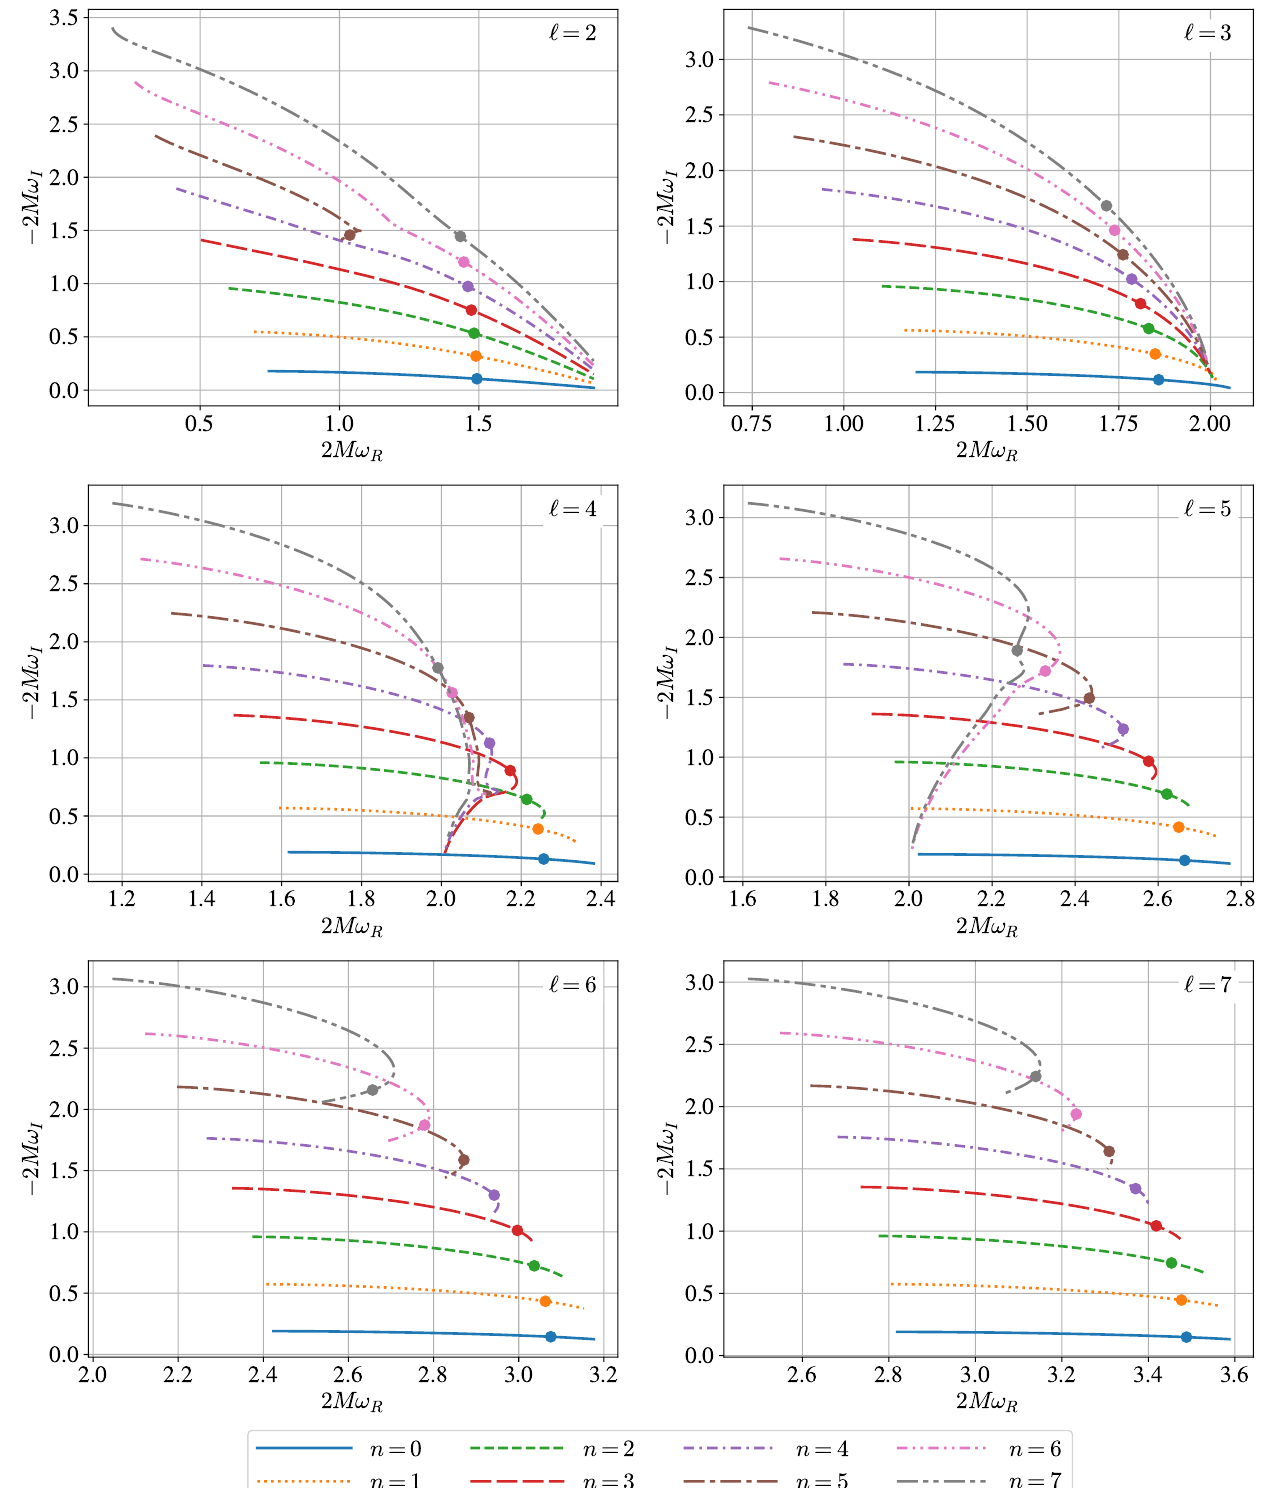
Figure A5. Fundamental tone and overtones of Kerr QNMs for m = (cid:96) modes. Here, ω R and ω I mean the real and imaginary parts of the QNM frequency, respectively. We plot the values for 2 ≤ (cid:96) ≤ 7 in the range of the nondimensional spin of 0 ≤ χ ≤ 0.999. The filled circles show the QNM values at χ = 0.95. For χ ≤ 0.95, the n = 0 mode always has the highest real frequency and the slowest damping time. There is an interesting feature in the fifth overtone ( n = 5) of the m = (cid:96) = 2 mode. To make these plots, we use the QNM data provided in Ref.